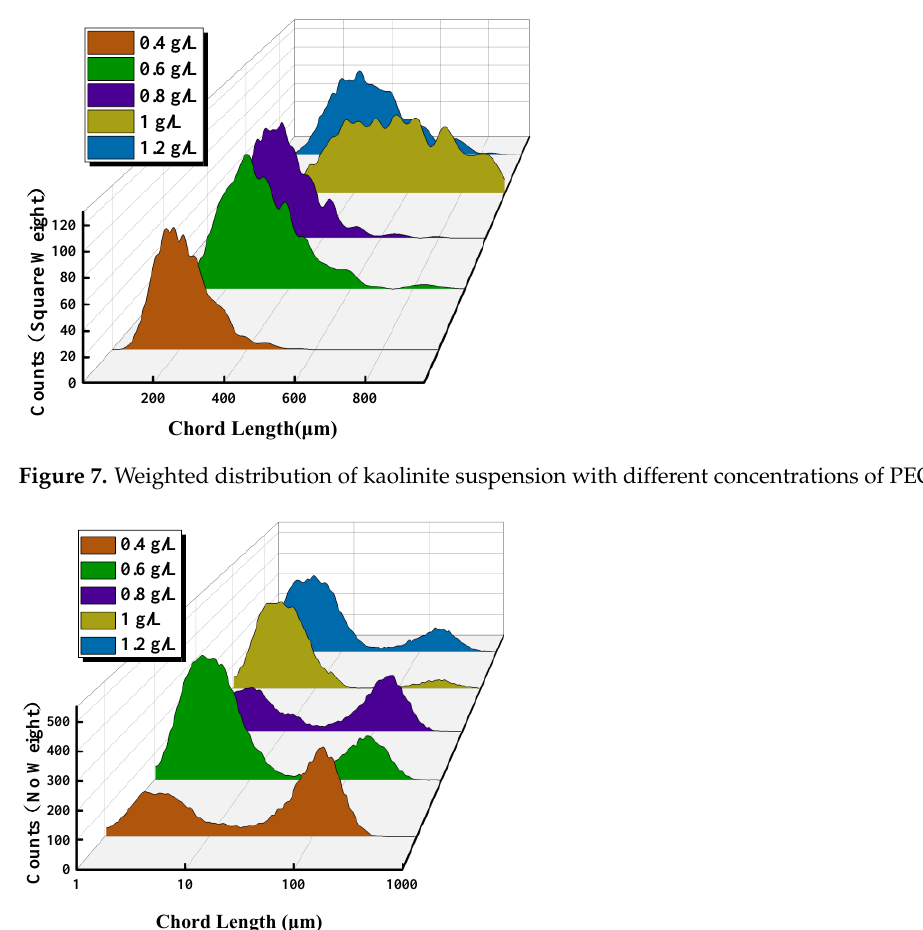
Figure 8. Unweighted distribution of kaolinite suspension with different concentrations of PEO.